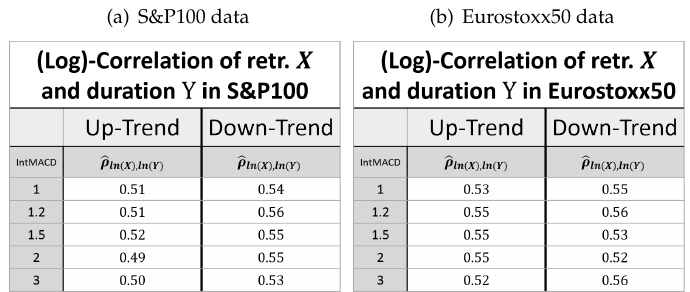
Table 5. Correlation between the logarithms of the retracement X (retr.) and its duration Y in up- and down-trends. ( a ) S&P100 data. ( b ) Eurostoxx50 data.